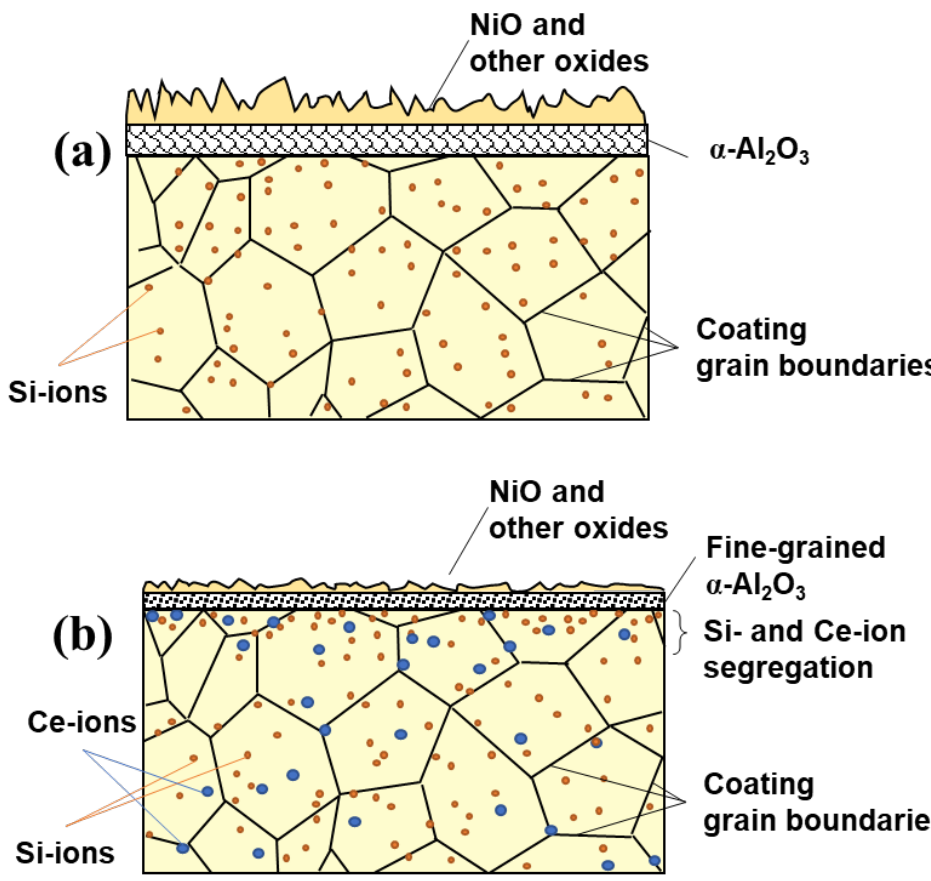
Figure 10. Mechanism of the oxide scale formation for ( a ) aluminide coating containing Si and ( b ) alumina coating containing both Si and Ce after cyclic oxidation test at 1100 °C for 50 cycles.